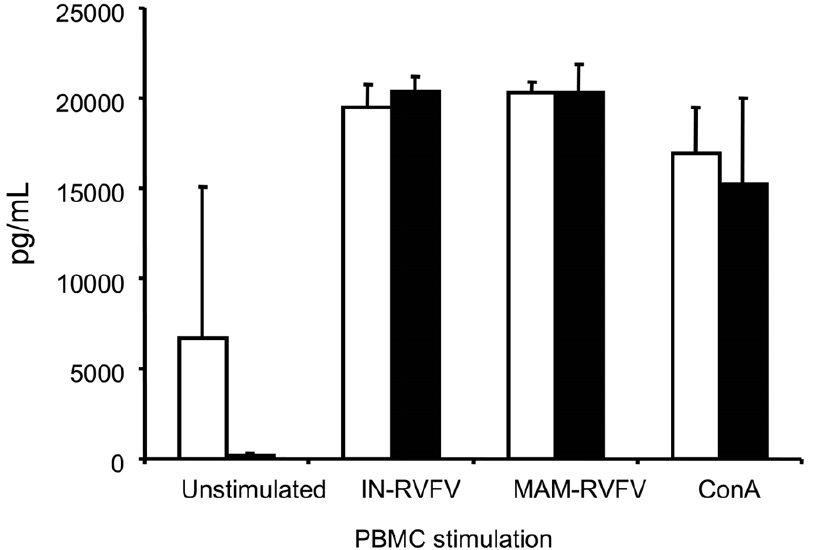
Figure 6. Adaptive cell mediated immunity in RVFV-infected goats. Means of PBMC IFN- c response from IN-RVFV-infected goats are represented by the open histograms and MAM-RVFV infected goats by the filled histograms. Error bars represent standard deviation of means (n=4 goats each). MAM-RVFV=RVFV produced in the mammalian cell line Vero E6, IN-RVFV=RVFV produced in the insect cell line C6/36.